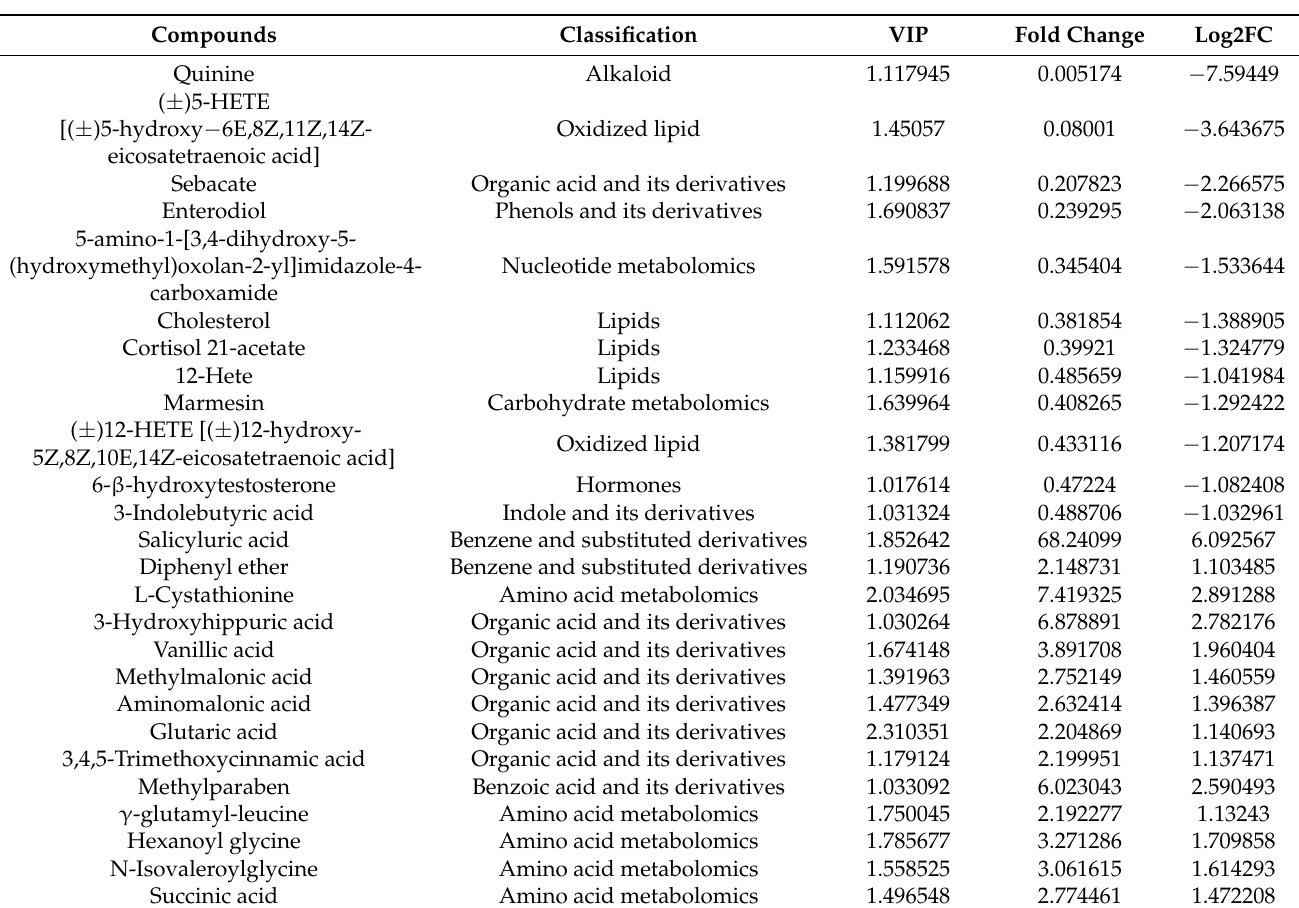
Table 5. The longissimus muscle metabolites that differ significantly in the goat samples after feeding A. sinensis leaves using UPLC-MS/MS